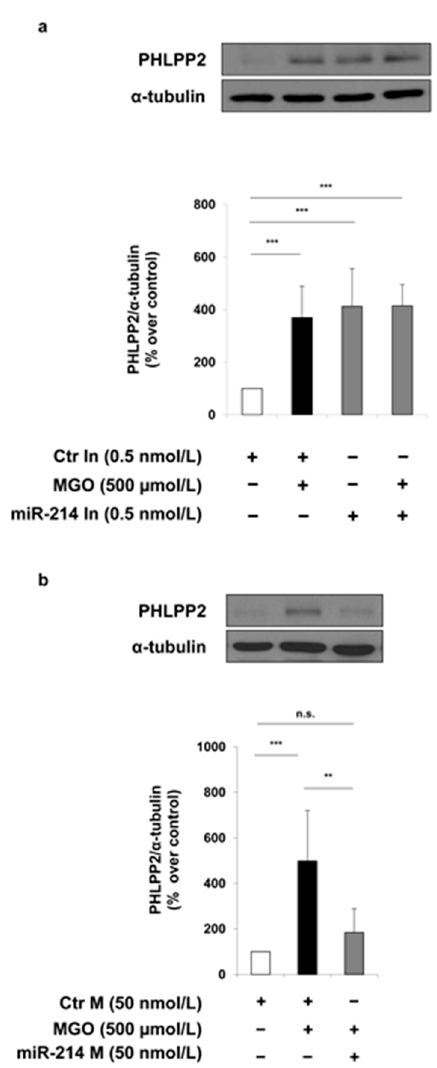
Figure 3. Effect of miR-214 mimic and miR-214 inhibitor on PHLPP2 levels in MAECs with or without MGO. MAECs were transfected with a non-targeting antisense inhibitor (Ctr In 0.5 nmol/L; ( a )) and a non-targeting control oligonucleotide (Ctr M 50 nmol/L; ( b )) (white and black bars), with miR-214 inhibitor (miR-214 In 0.5 nmol/L; ( a )) or miR-214 mimic (miR-214 M 50 nmol/L; ( b )) (gray bars). Where indicated, MAECs were treated with 500 µ mol/L MGO for 16 h. Protein lysates obtained from these cells 48 h after transfection were analyzed by Western blot with anti-PHLPP2 and anti- α -tubulin antibodies. Exposure timing was of 2 min for PHLPP2 blots and 10 min for α -tubulin blots. Protein levels were quantified by the densitometric analysis of at least three independent experiments. Bars in the graphs represent the mean ± SD of the percent (%) over control (Ctr M and Ctr In). Statistical analysis was evaluated using the Student’s t -test; ** p ≤ 0.01; *** p ≤ 0.001.